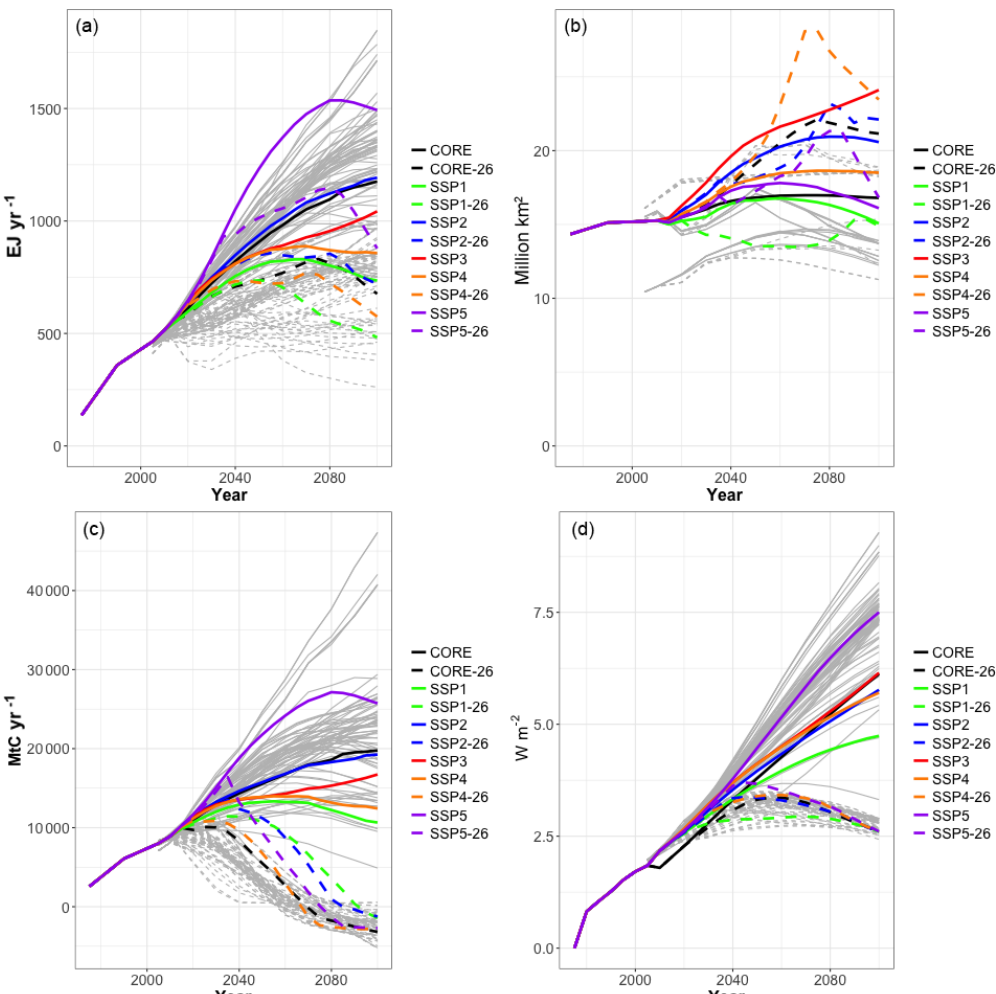
Figure 16. Global primary energy (a) , global cropland (b) , global fossil fuel and industrial CO 2 emissions (c) , and total radiative forcing (d) . Solid gray lines are no climate policy scenarios from the AR5 database (Clarke et al., 2014), i.e., scenarios with a carbon price of USD0 in 2100. Dashed gray lines are scenarios in the AR5 database that are roughly consistent with 2.6Wm − 2 ; specifically, we include any scenario with 2100 radiative forcing below 2.9Wm − 2 . Black and colored lines are the GCAM v5.1 scenarios, with the color indicating the socioeconomic scenario and the line type indicating the climate policy (no policy is represented by solid lines, and 2.6Wm − 2 is represented by dashed